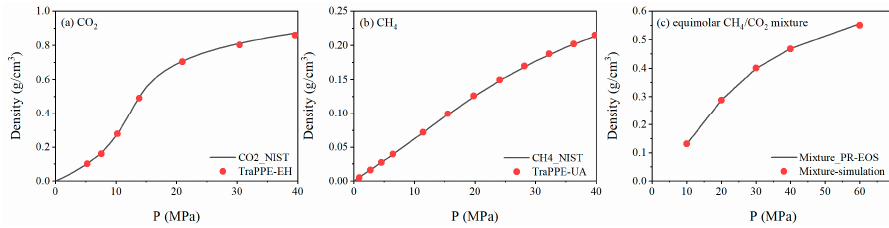
Figure 2. Force field verification of ( a ) CO 2 , ( b ) CH 4 , and ( c ) equimolar CH 4 /CO 2 mixture. T = 338 K.